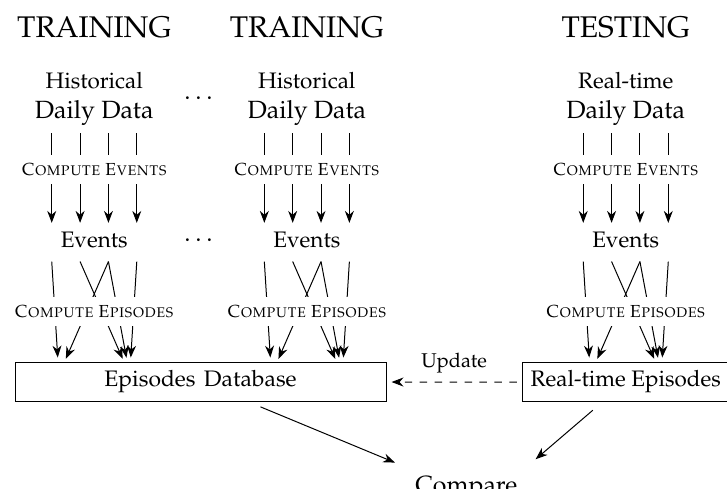
Figure 1. Overview of consensus-based FDD method. Events are computed for each time-series from historical data. Episodes, i.e., sequences of events belonging to different time-series, are used to construct a database containing the normal qualitative behaviour. At run-time, events and episodes are computed from real-time data and compared with the database, and optionally added to the database.